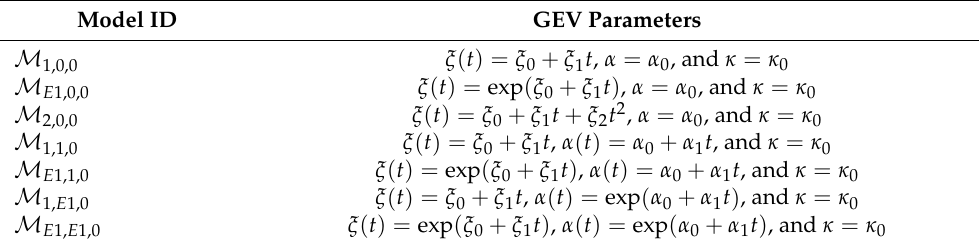
Table 1. Candidate Nonstationary Structures in the nonstationary flood frequency analysis (NS-FFA). GEV = generalized extreme values